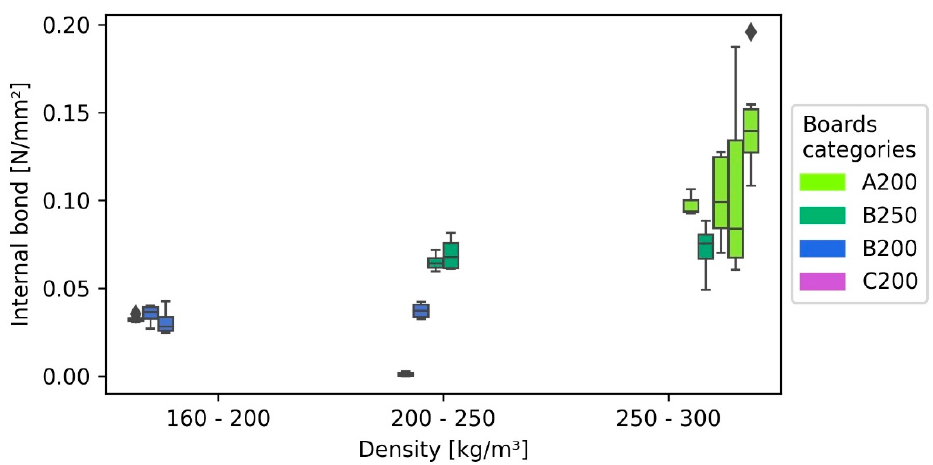
Figure 5. Internal bond of the insulation panels with 1.6, 4, and 7 mm bark fibre length as a function of density.